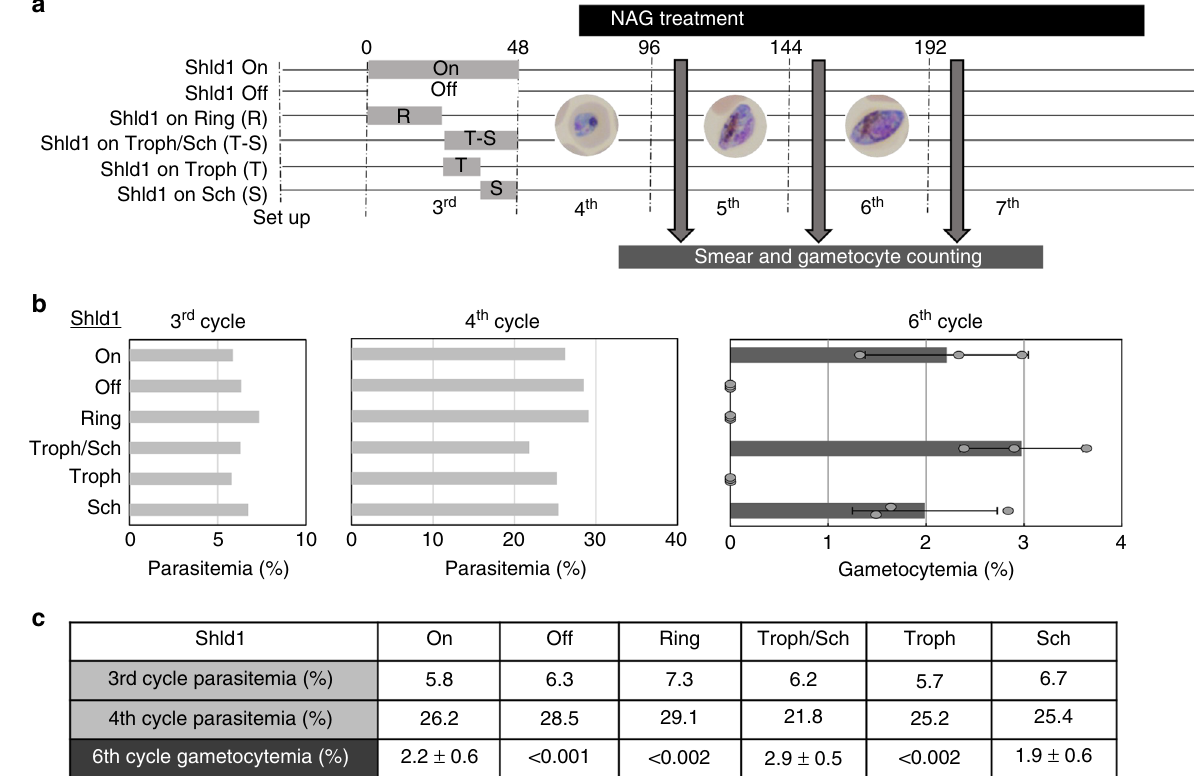
Fig. 6 GDV1 expression during schizogony is critical for gametocyte production. a Schematic of the experimental design. Pfgdv1.gfp.dd .T1 parasites grown in the absence of Shld1 until the parasitemia reached 4 – 6% rings were divided into 6 wells and Shld1 was added only for the following time intervals: Shld1 On) 1 – 48 h, Shld1 Off) 0 h, Shld1 on Ring) 0 – 24 h (R), Shld1 on Troph/Sch) 24 – 48 h (T-S), Shld1 on Troph) 24 – 36 h (T), Shld1 on Sch) 36 – 48 h (S). The following asexual cycle NAG (50 mM) was added at the trophozoite stage (~72 h) and continued for the course of the experiment. Culture smears were made at each cycle to track parasite development and a Giemsa-stained image of the predominant parasite stage is shown. b The mean parasitemia for each condition in the 3rd and 4th cycle as well as the mean ± s.d. gametocytemia in the 6 th cycle are plotted and the values are listed ( c ). The experiment was repeated twice and the data shown is from one representative